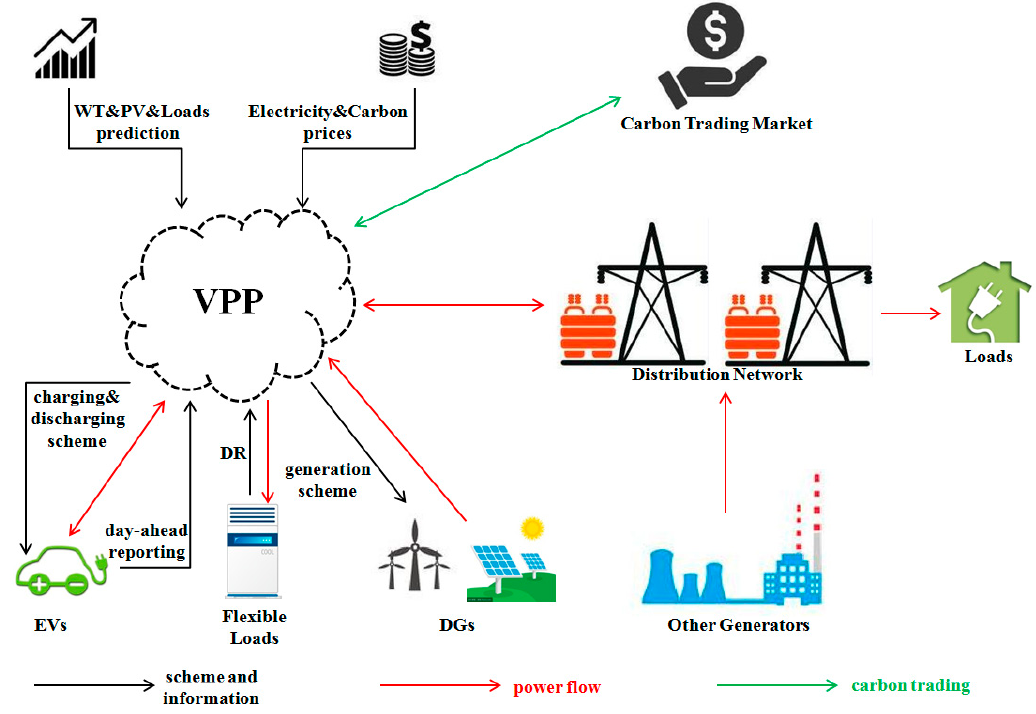
Figure 1. Illustration of the dispatching procedure in a VPP.